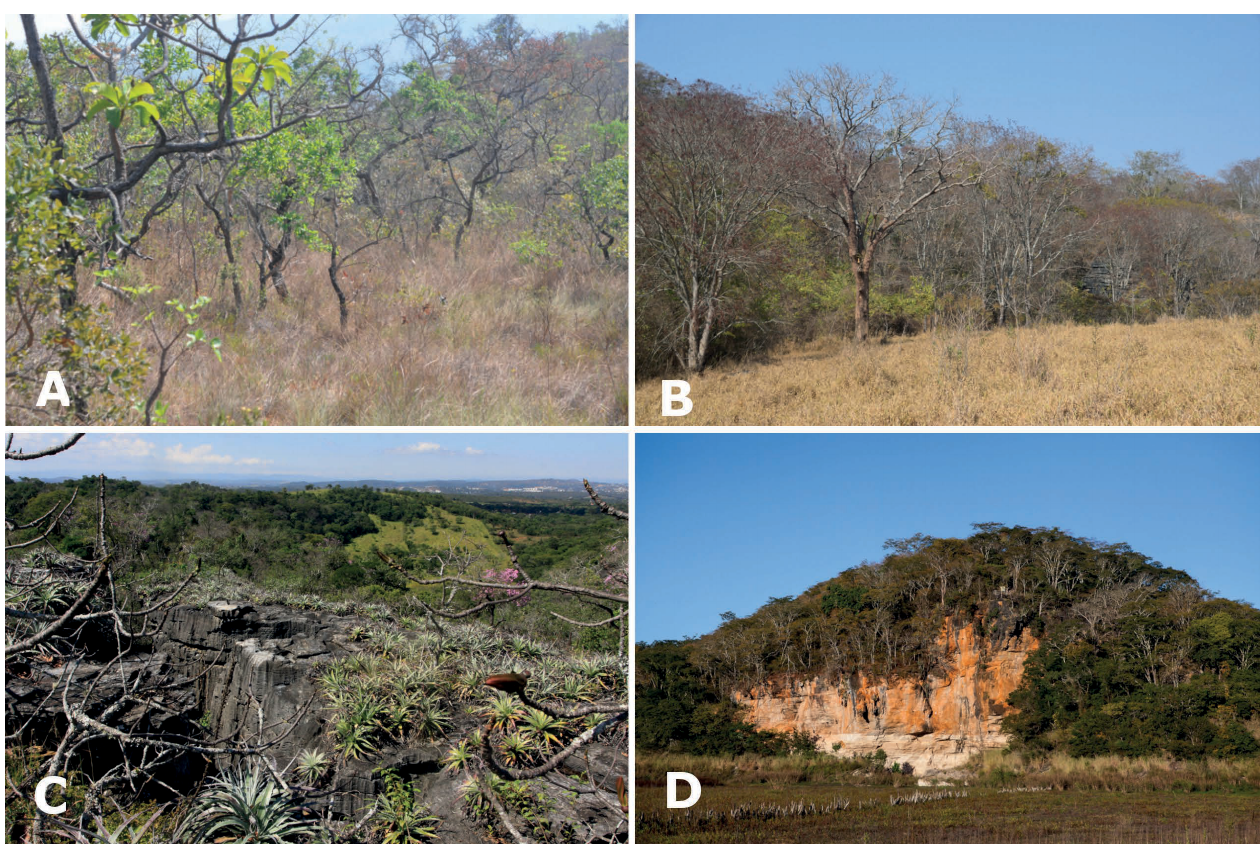
Figure 2 – Phytophysiognomies of Lagoa Santa, Minas Gerais, Brazil, where E. Warming during about three years (1863–1866) collected 2270 species of flowering plants for the Florula Lagoensis . A . Cerrado, a savannah-like vegetation. B . Seasonal dry forest, deciduous during the winter. C . Massifs (carbonate rocks), with saxicolous plants. D . Lake, during the dry season. Photographs by J.R. Stehmann (A, B); C.P. Schlindwein (C) and C. Palhares